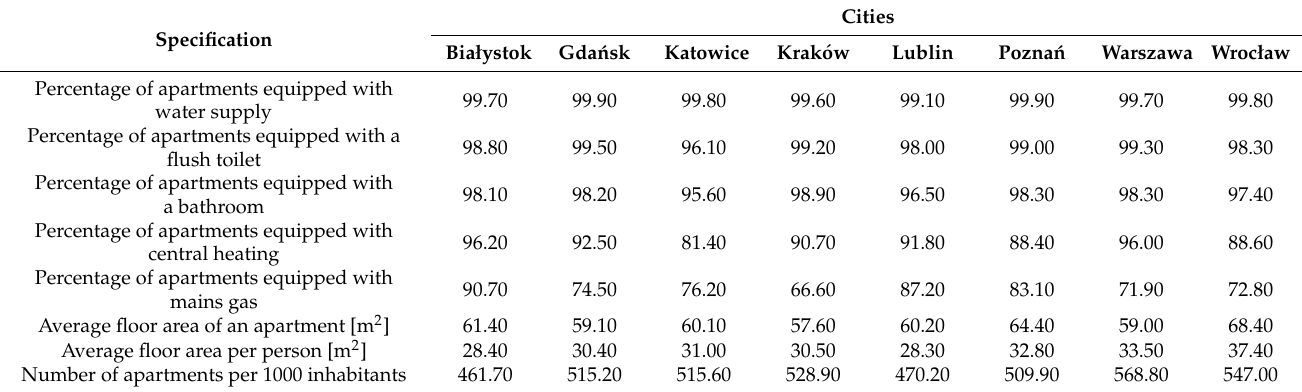
Table 2. Indicators characterizing the availability and quality of housing infrastructure in the sur- veyed cities and provinces—comparative